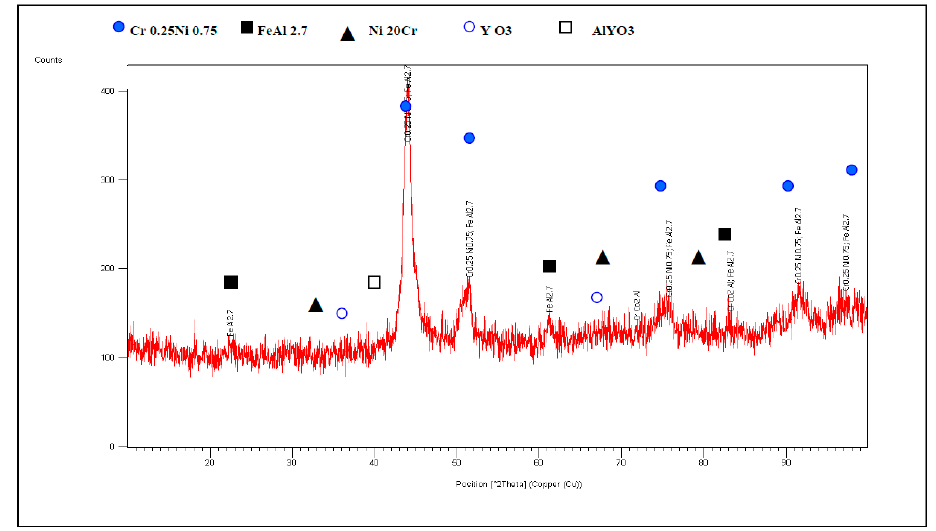
Figure 10. Indexing map of the X-ray diffraction pattern of textured matrix Ni20Cr10Al2Y. (2-Theta,